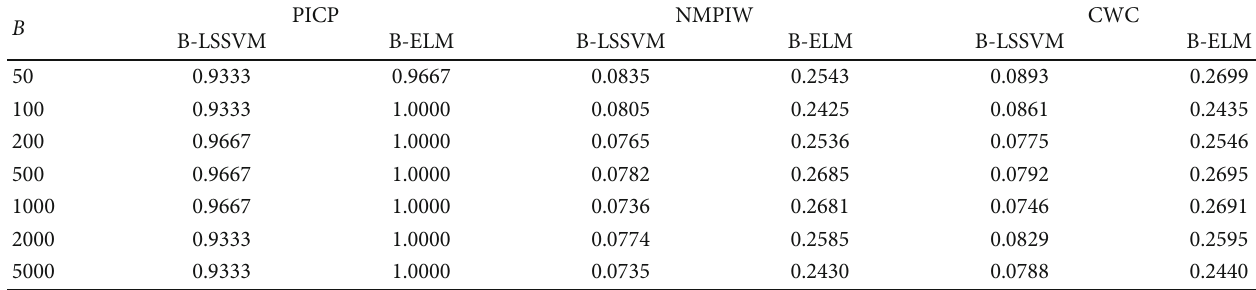
Table 1: PI performance index of ZG287.